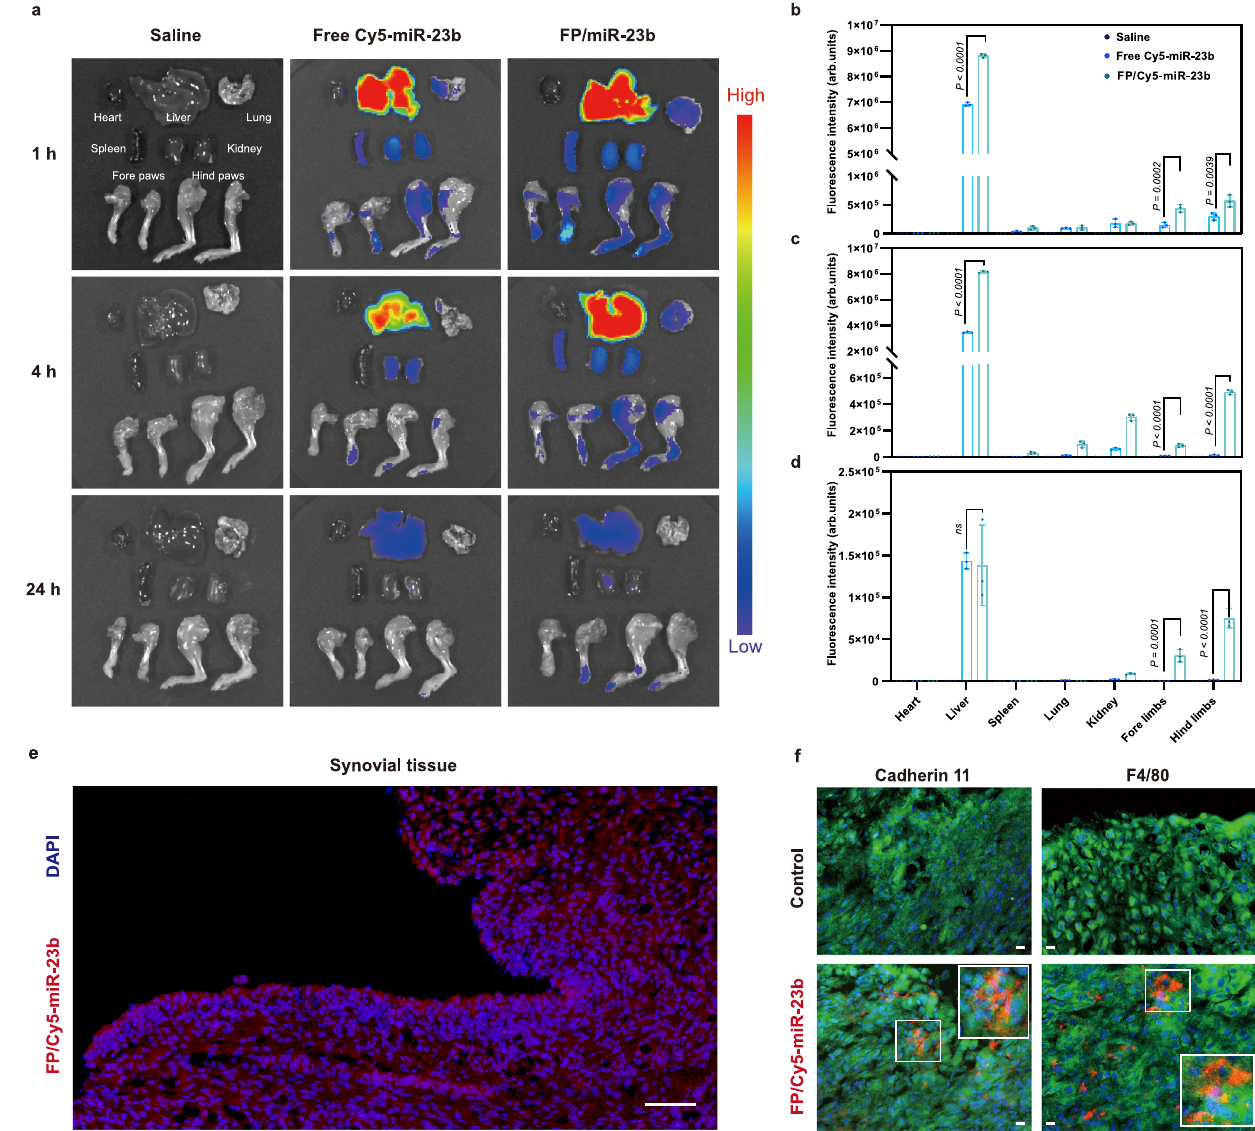
e Distribution of FP/Cy5-labeled miR-23b nanoparticles in the synovium of CIA mice. Nuclei, blue (DAPI); Cy5-labeled miR-23b, red. Scale bar: 100 μ m. A repre- sentative image of three biologically independent samples is shown. f Distribution of FP/miR-23b nanoparticles in the synovial macrophages and fi broblasts. The macrophagesand fi broblastsweredetectedbyimmuno fl uorescenceanalysisofF4/ 80and cadherin 11, respectively. Nuclei, blue (DAPI);Cy5-labeledmiR-23b,red;F4/ 80 or cadherin 11, green. Scale bar: 50 μ m. A representative image of three biolo- gically independent samples from each group is